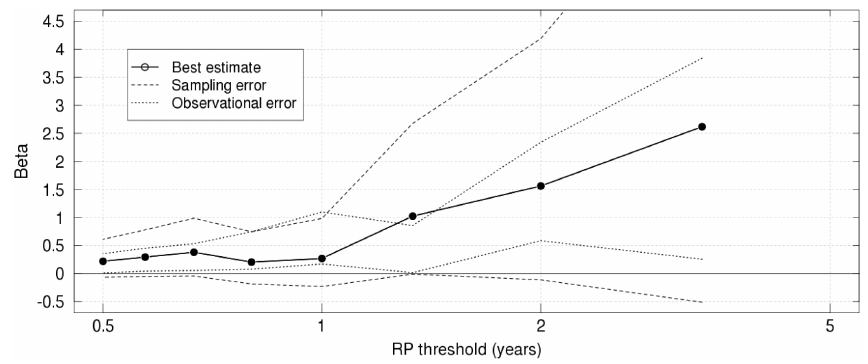
Figure 6. Clustering strength ( β ) as a function of the storm severity groupings for historical storms in the EU-RMS-42 data set. The dashed lines show the 95th confidence interval based on sampling error, and the dotted lines represent the 95th confidence interval of observational